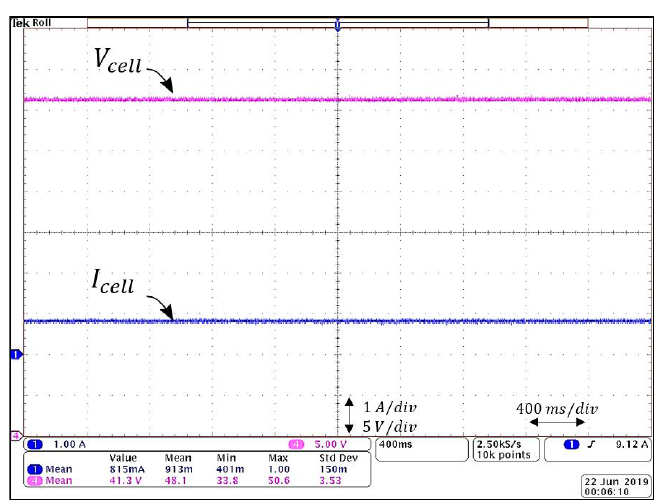
Figure 9. V cell and I cell waveforms corresponding to the A point operating point in Figure 8.